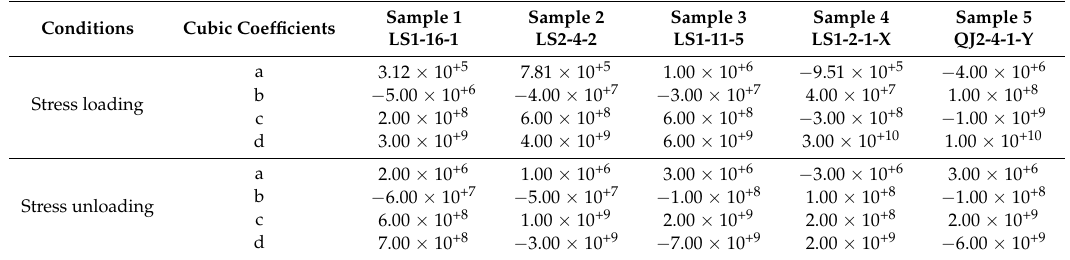
Table 2. Cubic equation correlations for numerical model